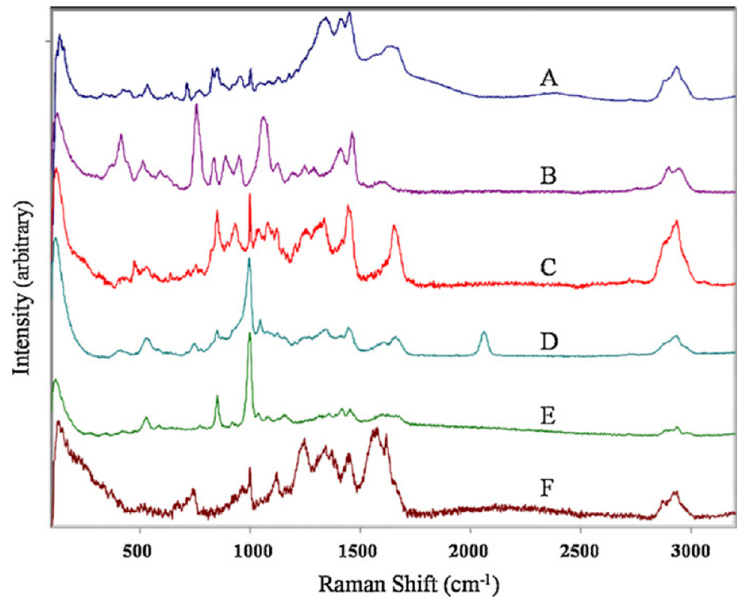
Figure 3. Raman spectra of human semen ( A ), canine semen ( B ), vaginal fluid ( C ), saliva ( D ), sweat ( E ) and blood ( F ). Reproduced from reference [24].